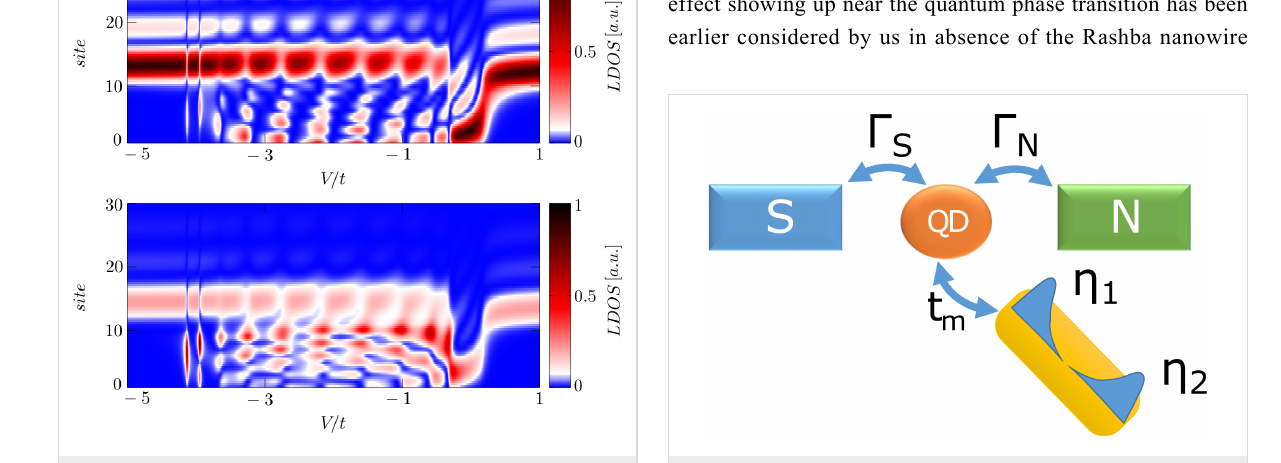
Figure 6: Leakage of the spin-polarized Majorana quasiparticles from the topological superconducting phase of the Rashba chain ( i ≥ 10) onto the side-attached multi-site ( ) quantum dot. The upper and bottom panel show ρ i σ ( ω ) at ω = 0 for ↑ and ↓ spin, respectively.